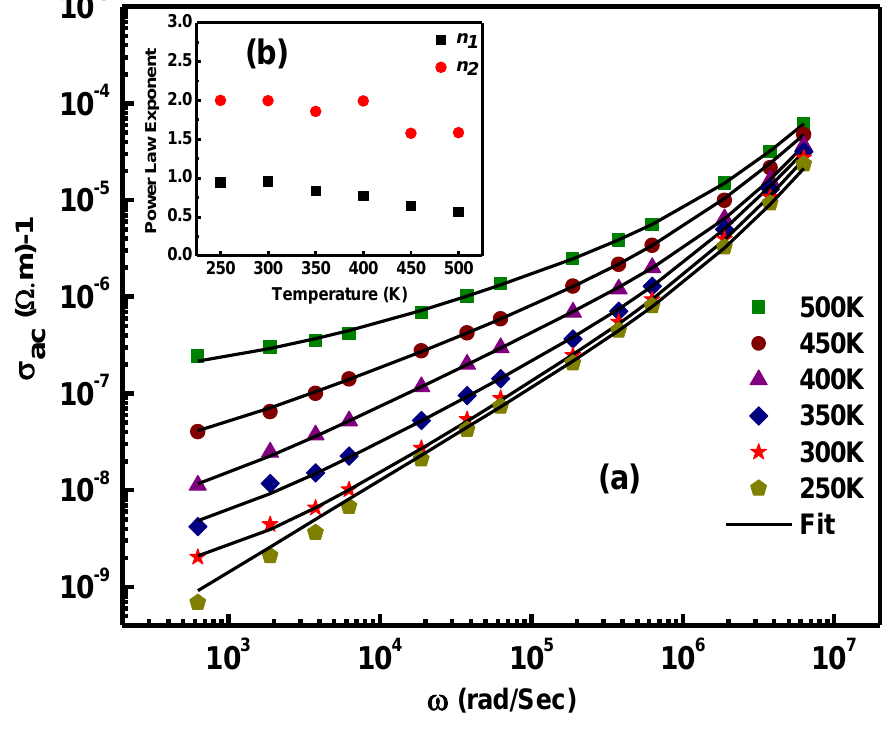
) as a function of frequency in the 250–500 K ac